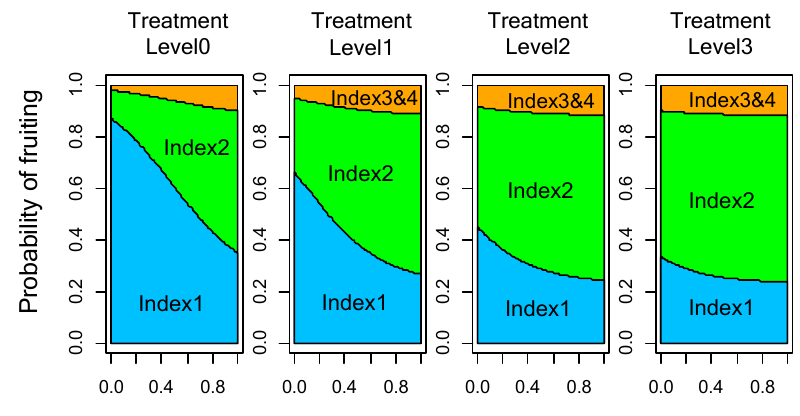
Figure 2. Relationship between fruiting probability of trees and light intensity (relative photosynthetic photon flux density) for di ff erent girdling treatment levels. Blue: fruiting index 1, trees not producing female cones. Green: fruiting index 2, trees producing female cones sparsely within their crown. Orange: fruiting index 3, trees producing abundant female cones within their crown.